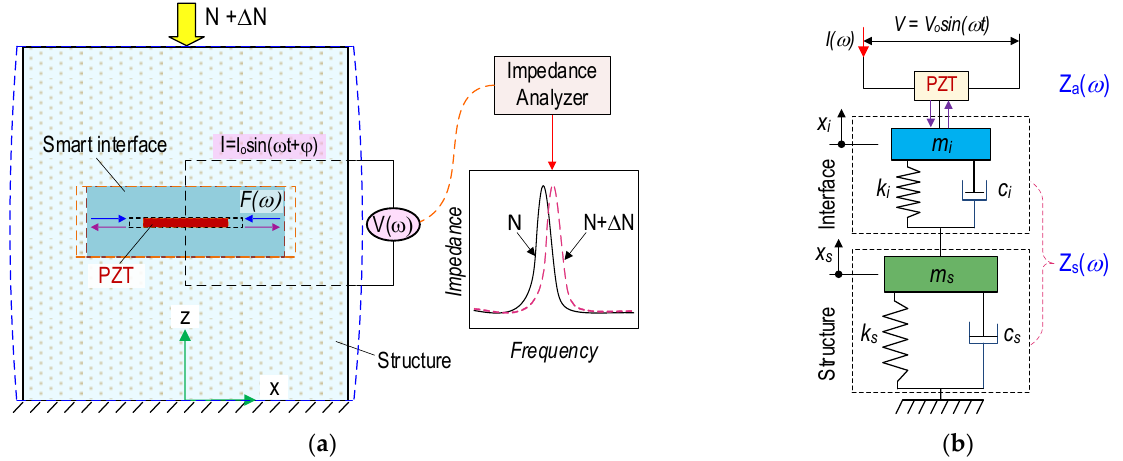
Figure 4. PZT-embedded smart interface for impedance monitoring in concrete structure: ( a ) Concrete structure embedded with a smart interface; ( b ) 2-DOF impedance model.